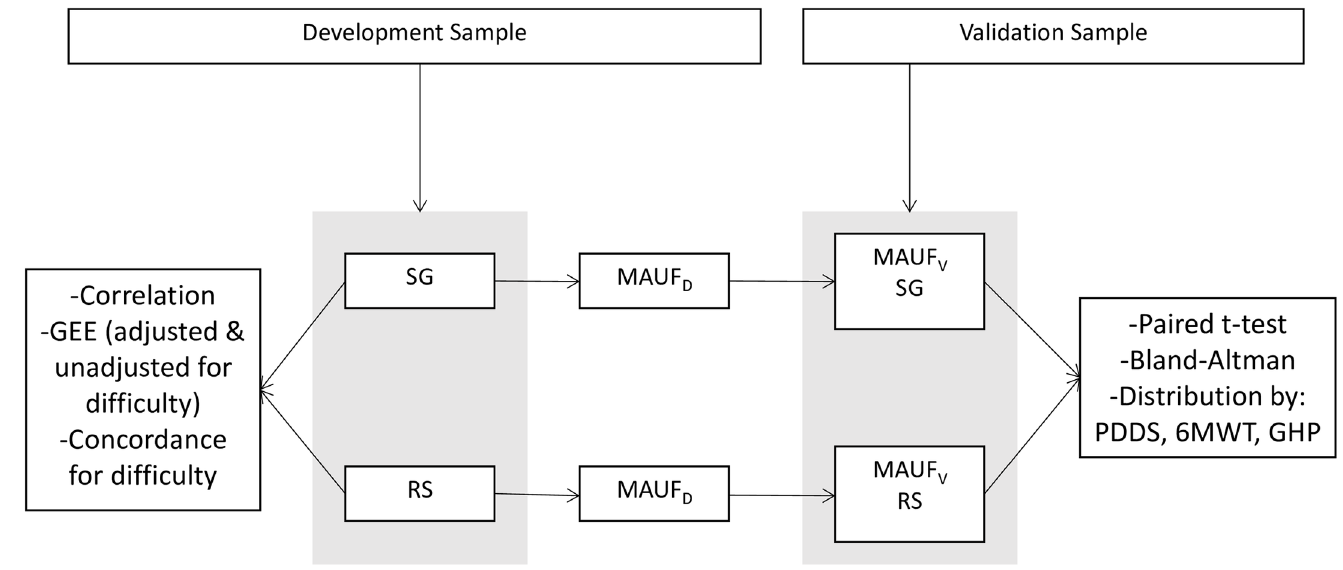
Fig 1. A flow diagram of the methodological steps involved in the